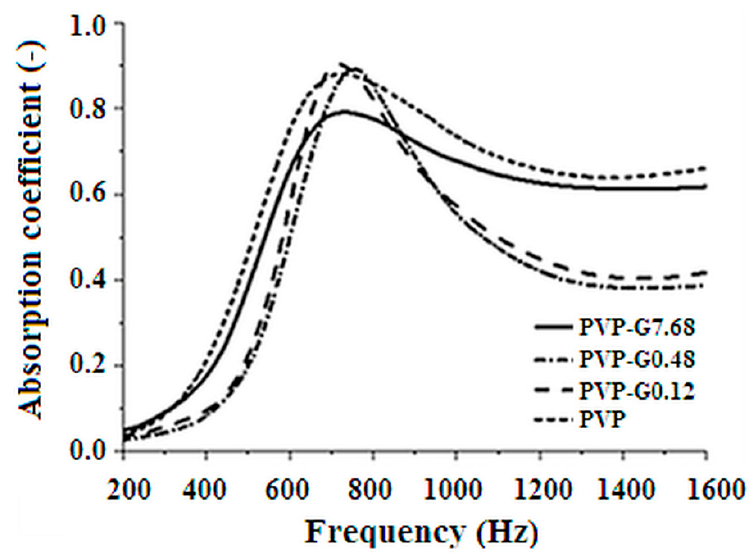
Figure 10. Sound absorption coefficient as a function of frequency.